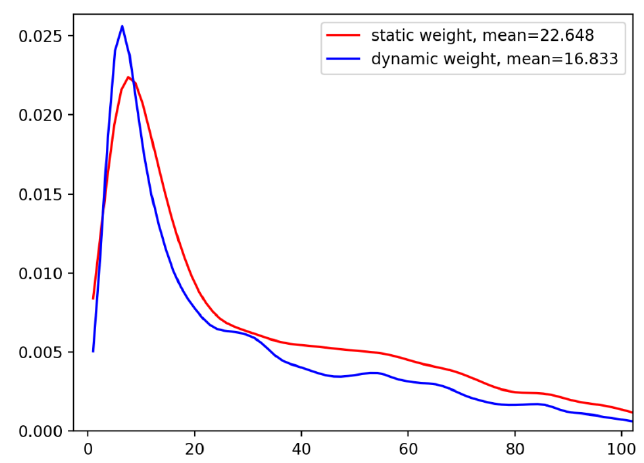
Figure 2. Perplexity of decoding output from the original shallow fusion and dynamic rescoring.